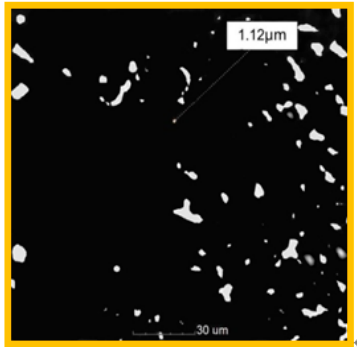
Figure 6. Pore image after processing.